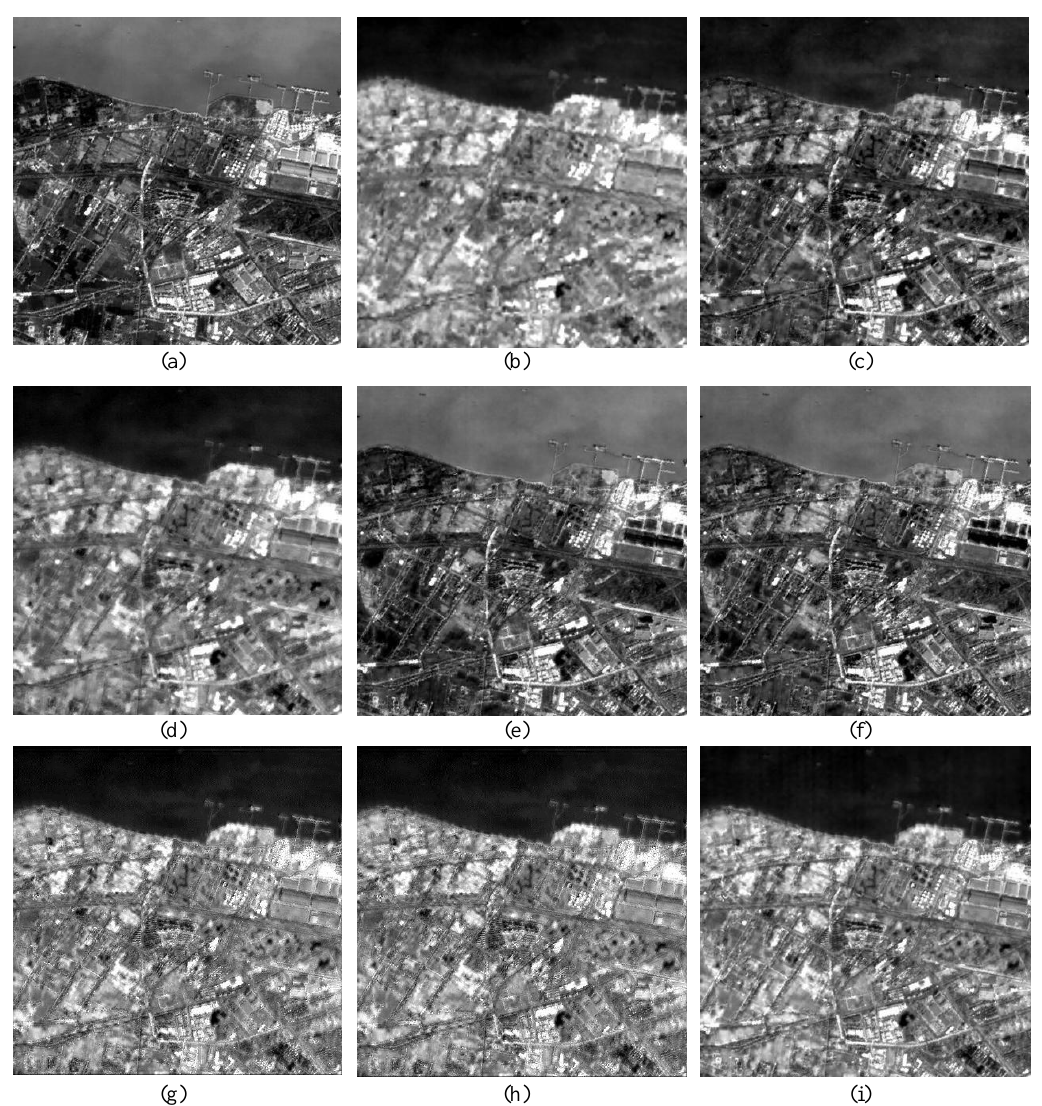
Figure 2. Original images and fused images from different methods in Shanghai City: (a) original HR image, (b) original HS image, (c) proposed method, (d) original variational method, (e) PCA, (f) GS, (g) SFIM, (h) MTF-GLP, (i) CNMF.